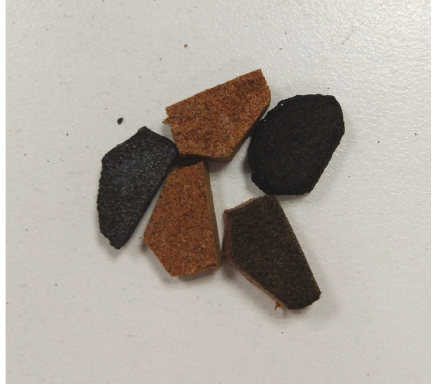
Figure 3: The sample to be observed.